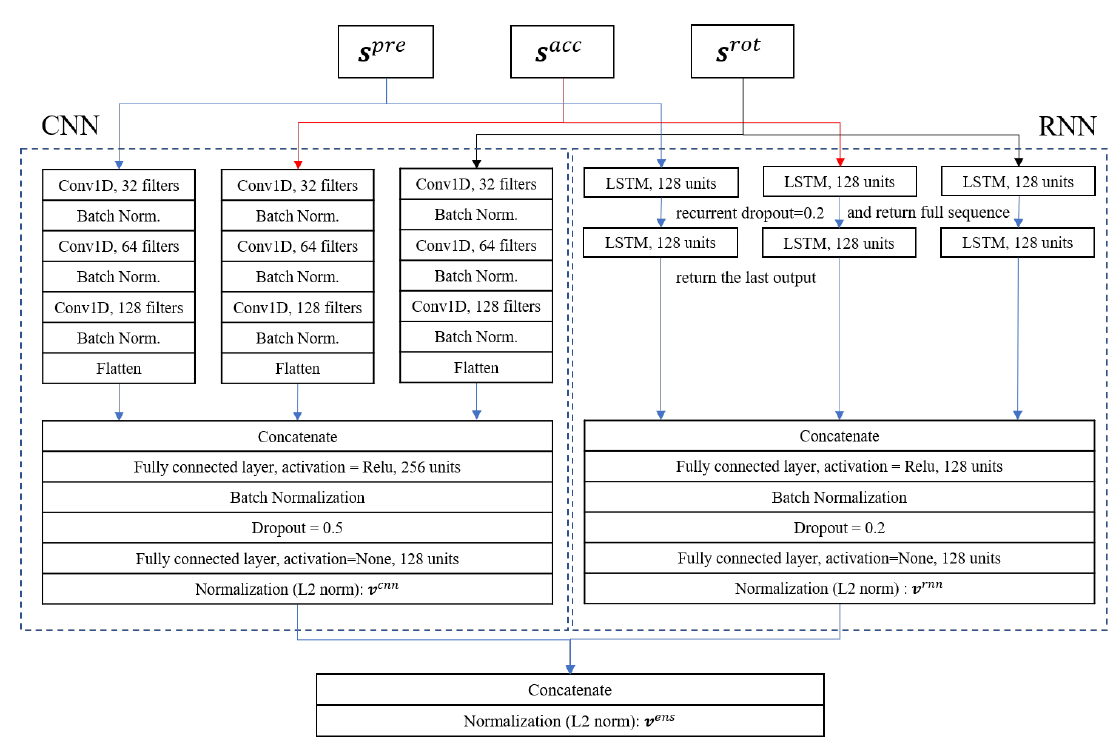
Figure 2. The design of the proposed network